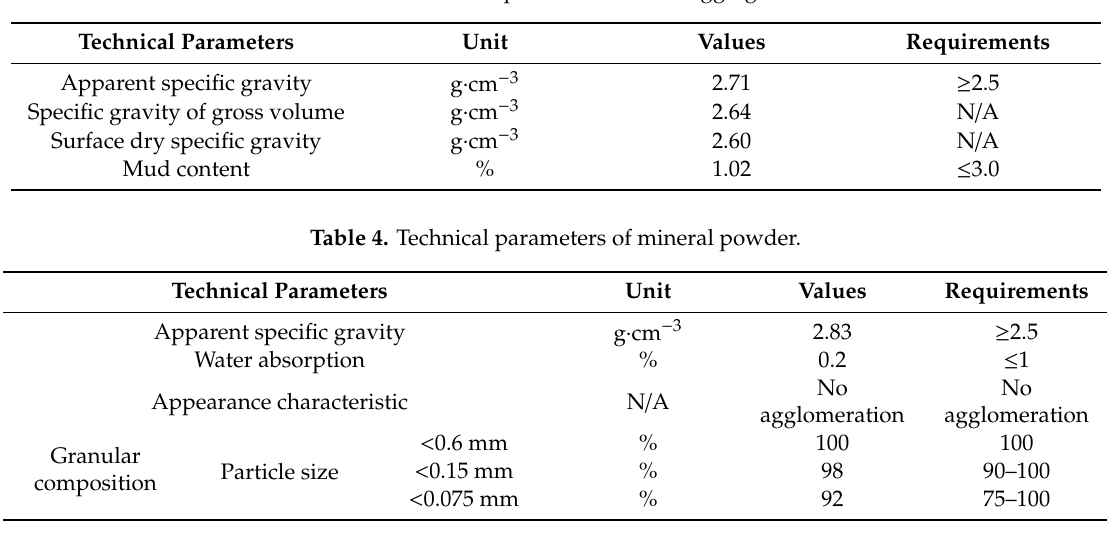
Table 3. Technical parameters of fine aggregate.